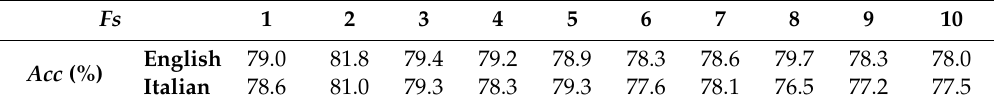
Table 8. Testing accuracy obtained by di ff erent filter sizes 1 .